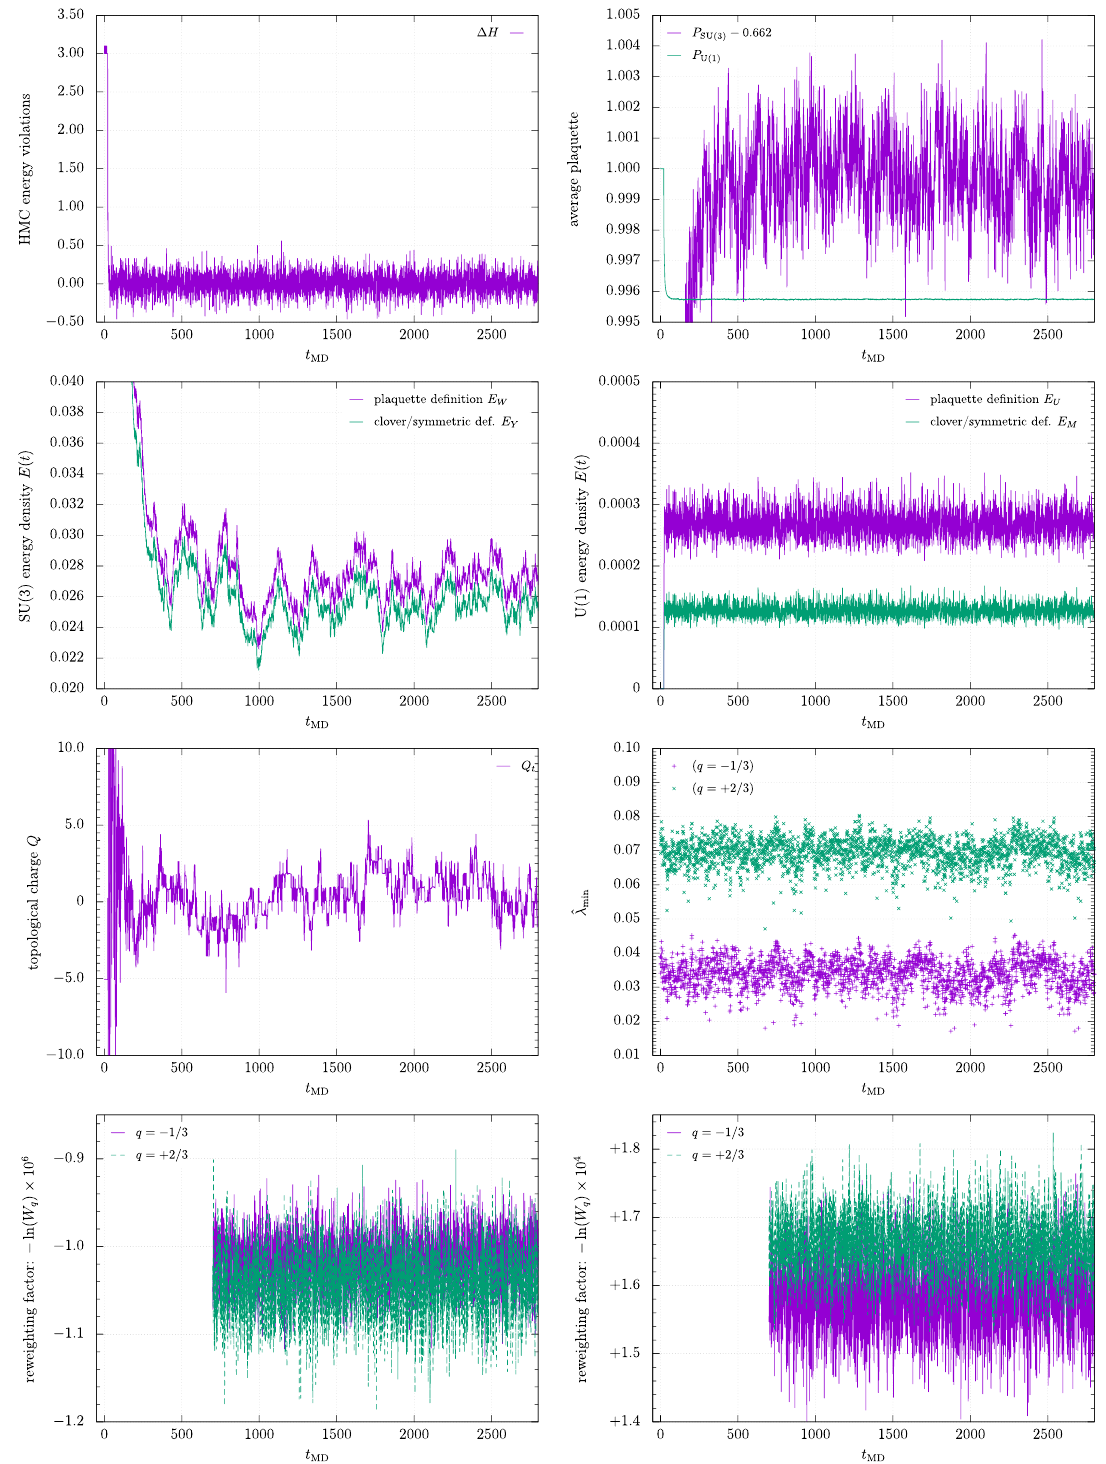
Fig. 8 Selected observables for simulation Q*D1 including thermali- sation part. Left–right/top–bottom: HMC energy violations (cid:9) H , aver- age plaquette for SU(3) and U(1) gauge fields, energy density E ( t ) for SU(3), energy density for U(1), topological charge Q ( t ) , lowest eigen-